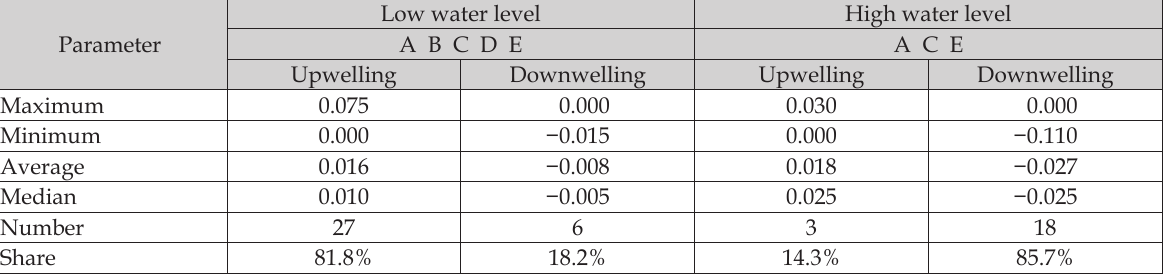
Table 5. Analysis of the hydraulic gradient results in the Moszczenica bottom at different water levels.